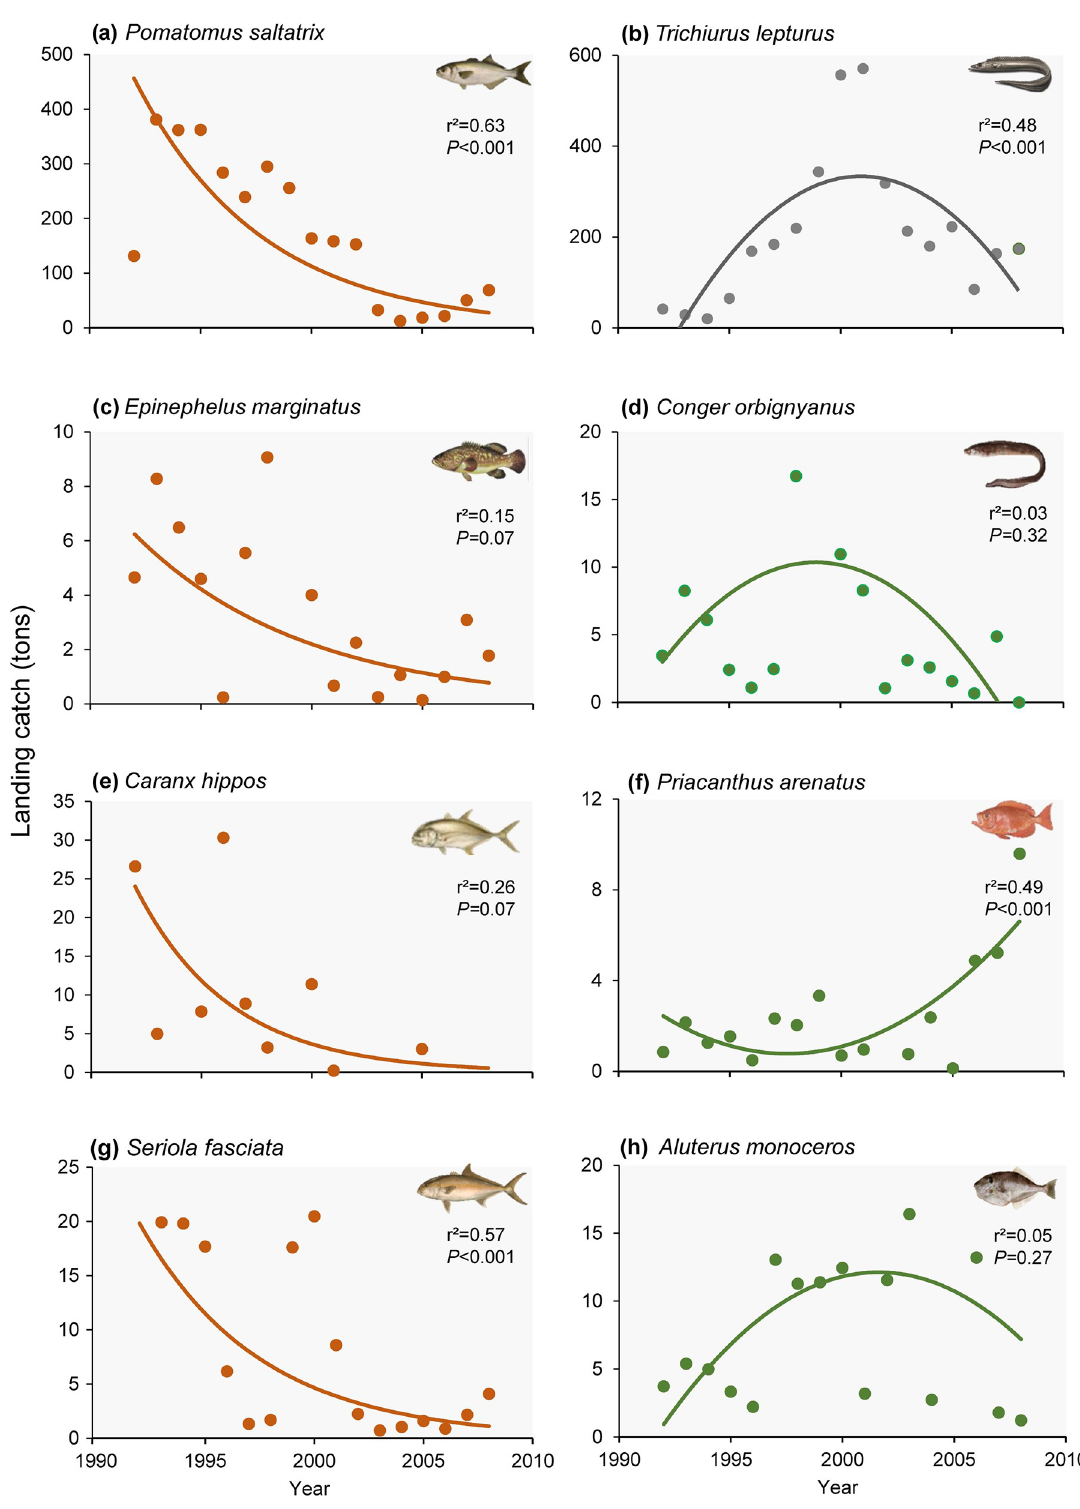
Fig 4. Artisanal fisheries (tons) landings in Arraial do Cabo from 1992 to 2008. Species on the left (a, c, e, g) correspond to those most frequently cited as overexploited in interviews and on the right (d, f, h), new target species reported by local fishers. (b) Trichiurus lepturus corresponds to both an overexploited and a new target species. a, b, d, f, g and h, are second-order polynomial regressions; c and e, an exponential regression.